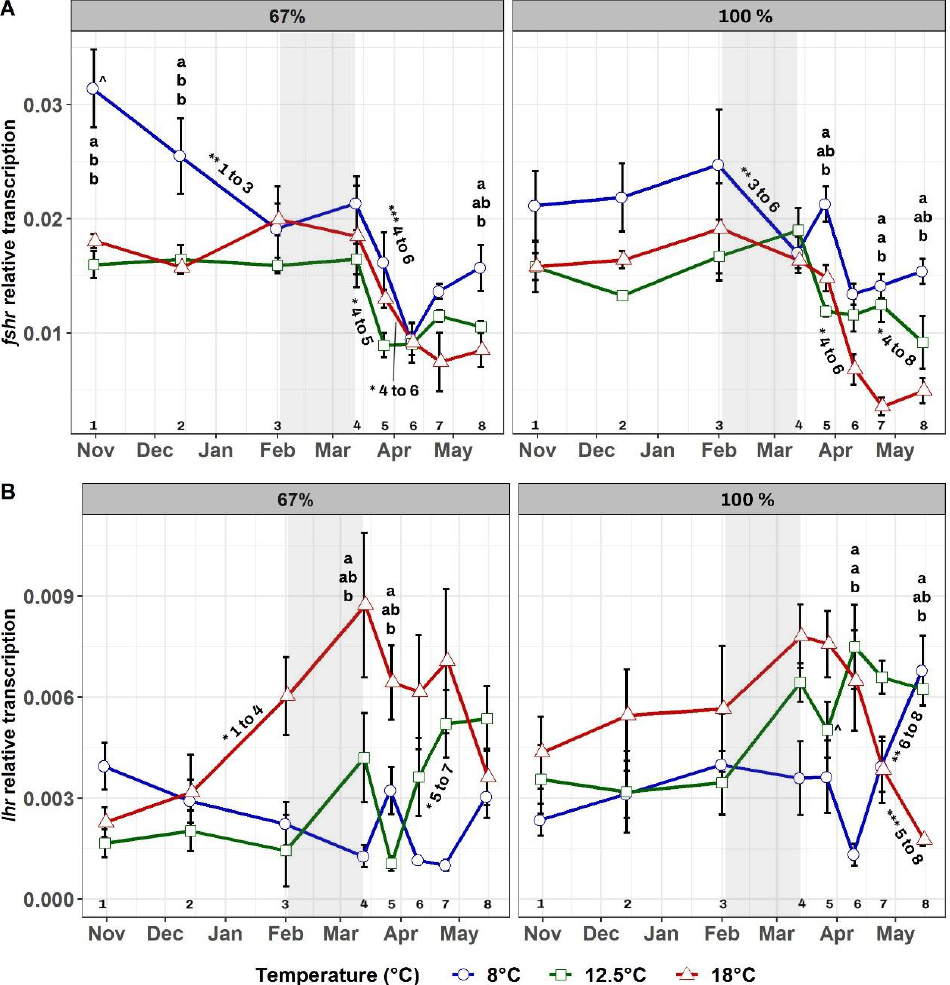
Figure 4. Mean testis fshr ( A ) and lhr ( B ) transcription over time in the six experimental groups. Feeding regimes are displayed separately, with the 67% groups shown on the left and the 100% ration groups on the right. The grey-shaded area shows the duration of the LD12:12 winter signal. Letters “a” and “b” indicate significant differences ( p < 0.05) between groups within a feeding regime for a given time. Signs “^” indicate significant differences ( p < 0.05) between groups reared at the same temperature but at different feeding regimes at a given time, and they are located next to the largest value of the pair. Numbers from 1 to 8 at the bottom of the graphs represent the sampling number and aid with an explanation of significant differences over time within each group. These are displayed with asterisks as follows: (*) p -value < 0.05, (**) p -value < 0.01, and (***) p -value < 0.001. Asterisks are located next to the corresponding line and are followed by the sampling numbers between which such significant difference occurred.